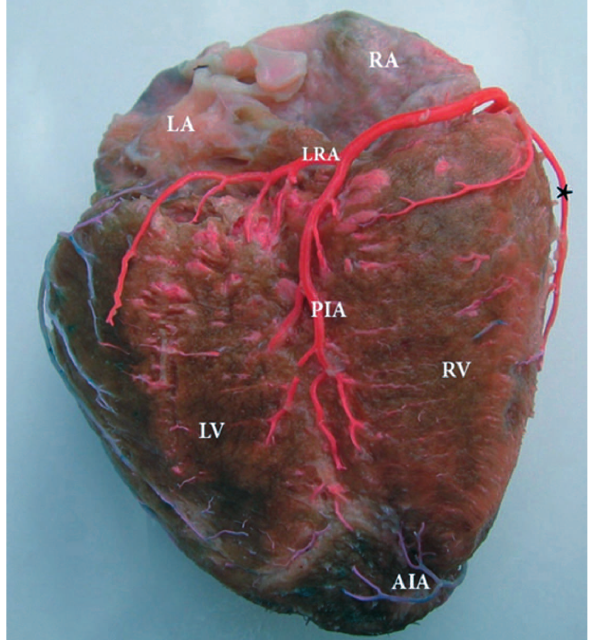
Fig. 1 - Posterior-inferior heart view. PIA: Short posterior interventricular artery. Right marginal artery (*). AIA: Anterior interventricular artery. LRA: Left retroventricular artery. RV: Right ventricule. LV: left ventricle. RA: Right atrium. LA: Left atrium